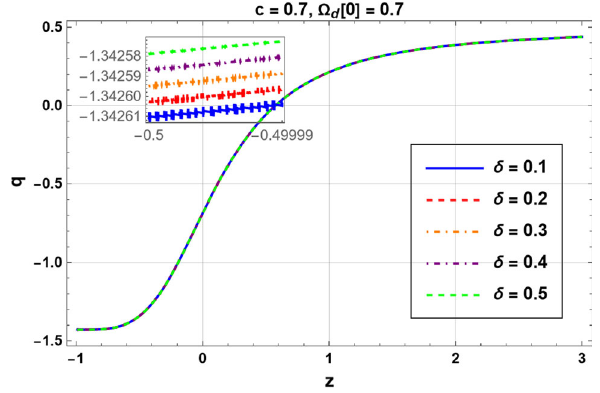
Fig. 3 The evolution of EoS parameter w d of NTHDE with δ = 0 . 2 and c = 0 . 8 to 1 . 2 is plotted w.r.t. redshift z by considering (cid:6) d [ z = 0 ] ≈ 0 . 7 , M 2 p = 1